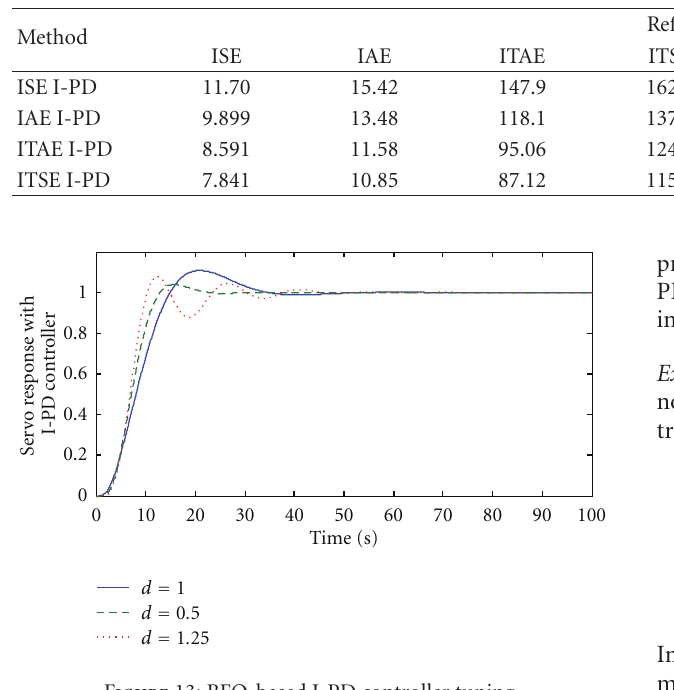
Figure 13: BFO-based I-PD controller tuning.